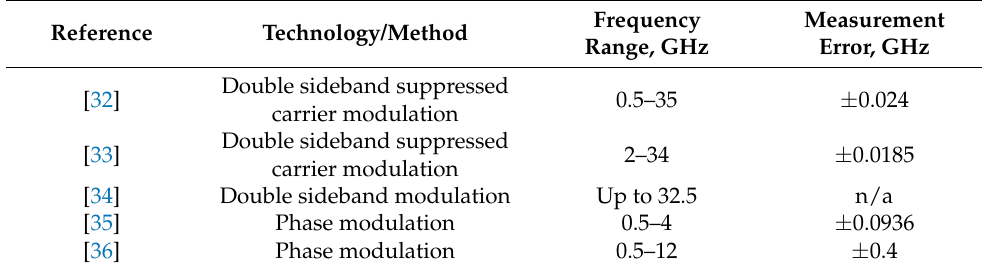
Table 4. Performance of IFM techniques based on microring resonators.